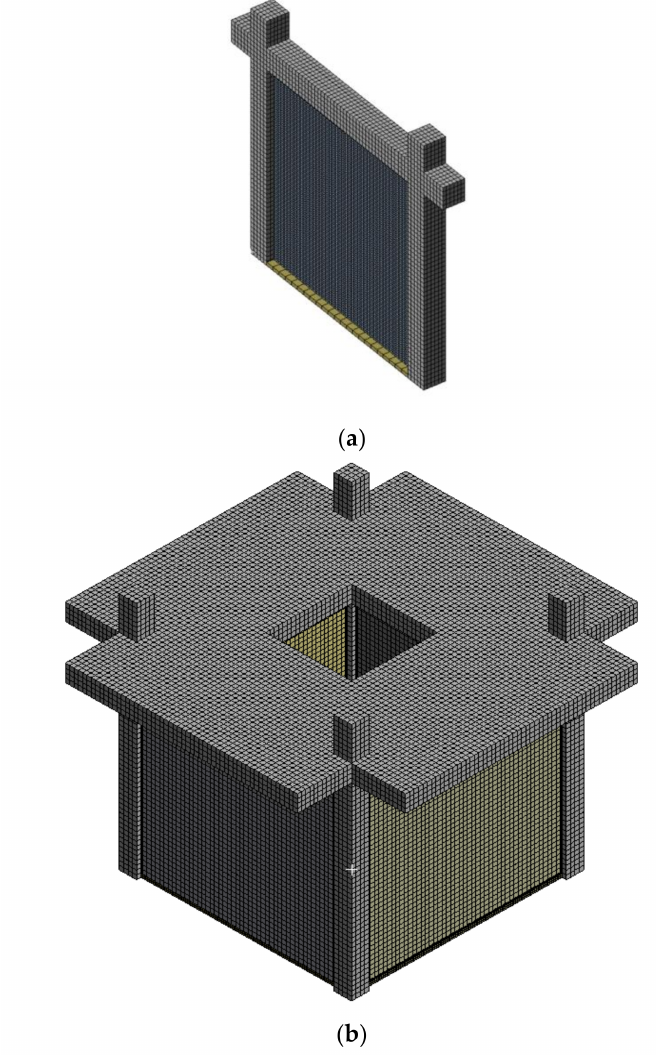
Figure 3. Geometry and mesh of the ( a ) A2R frame and of ( b ) 4-column model of INMASPOL